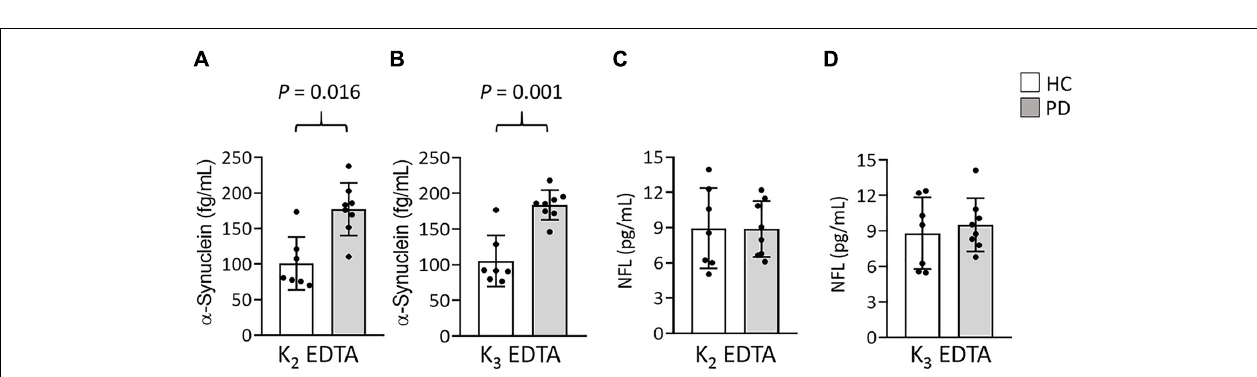
FIGURE 2 | Levels of α -synuclein and NFL in the plasma of patients with Parkinson’s disease (PD) and healthy controls (HCs). (A,B) Plasma levels of α -synuclein in patients with PD ( n = 8) and healthy controls (HCs, n = 7) in (A) K 2 - and (B) K 3 -EDTA tubes. (C,D) Plasma levels of NFL in patients with PD and HCs in (C) K 2 - and (D) K 3 -EDTA tubes. Error bars represent SD . Comparisons by Mann-Whitney U -test.